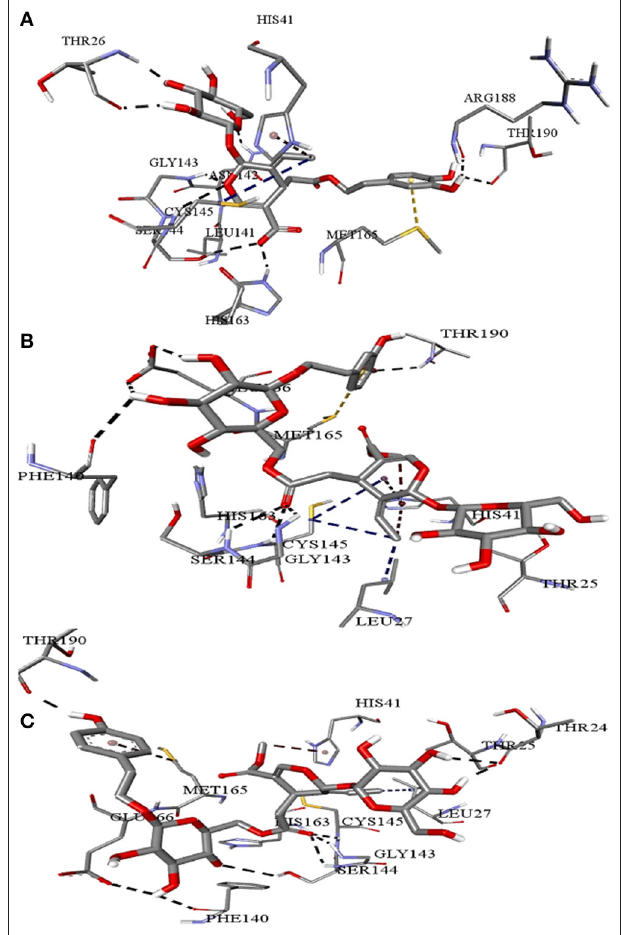
FIGURE 3 | Most active secoiridoids docked to SARS-CoV-2 main protease. (A) Demethyloleuropein (B) Neo-nüzhenide (C) Nüzhenide. The viral protease is in the CPK model. Mesh around the binding site represents it’s solvent accessible surface (SAS).